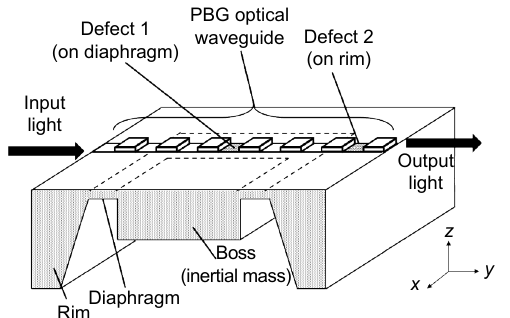
Fig. 23 | An early demonstration of MOEMS accelerometer based on photonic crystal. Figure reproduced with permission from ref. 138 , IEEE.